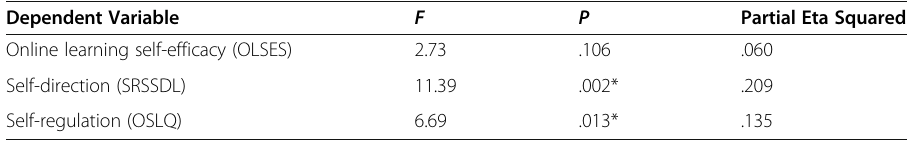
Table 3 ANCOVA results ( N = 48)